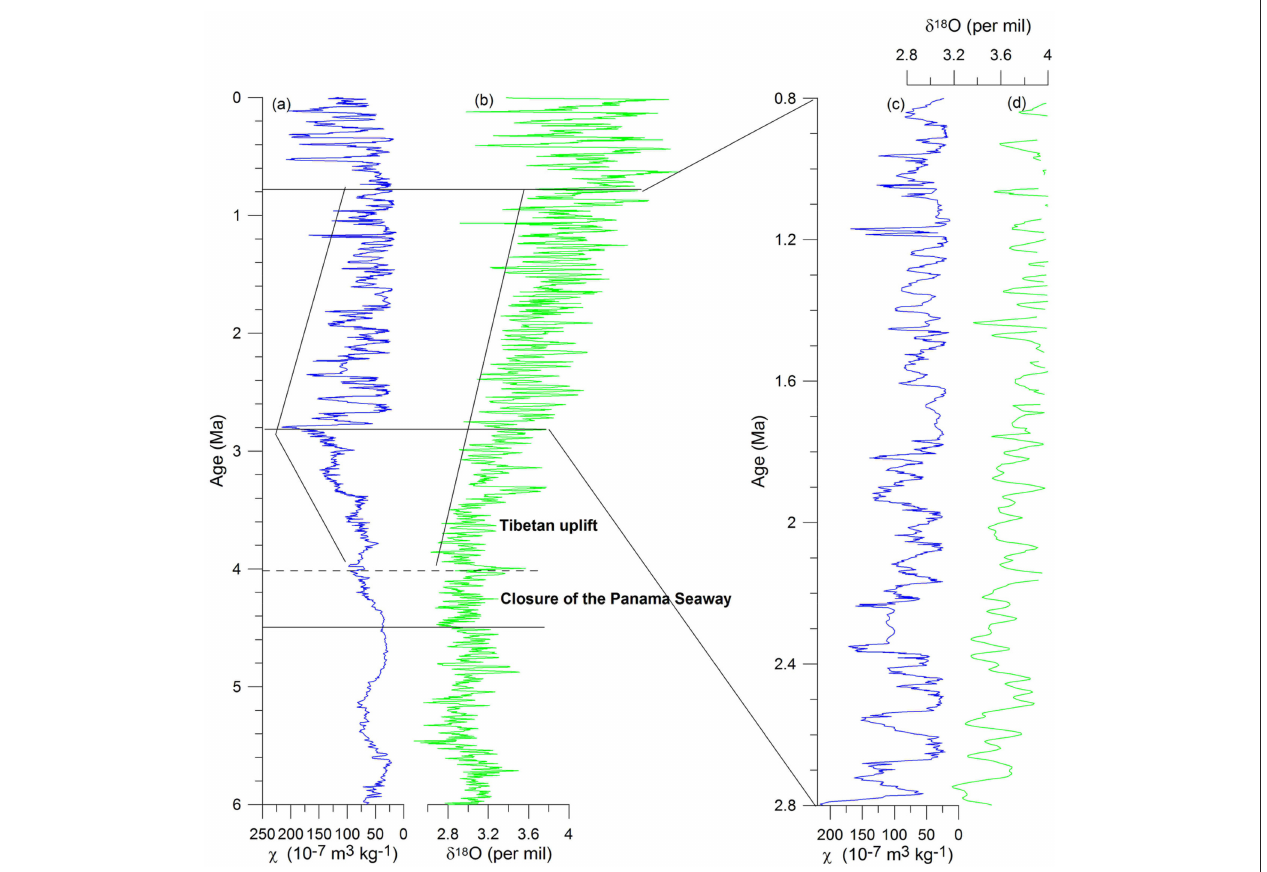
FIGURE 6 | Comparison between benthic oxygen isotope record ( δ 18 O) from the eastern Equatorial Pacific Ocean (Shackleton et al., 1990, 1995) and the χ record from the CLP during the last 6 Ma showing possible effects of ice volume and tectonic events to the EASM. (A) The χ record from Chaona between 6-0 Ma. The age model of the interval 2.8–0 Ma is based on orbital tuning (Heslop et al., 2000; Lü et al., 2001) and the age model of the interval 6–2.8 Ma is based on magnetostratigraphy (Song et al., 2001). (B) The benthic δ 18 O record between 6-0 Ma. (C) Is the 2.8–0.8 Ma portion of (A) . (D) Is the 2.8–0.8 Ma portion of smoothed (B) with values greater than 4 per mil clipped. In comparison with (A) and (B) , improved correlation between (C) and (D) is obvious. Modified from Nie et al.